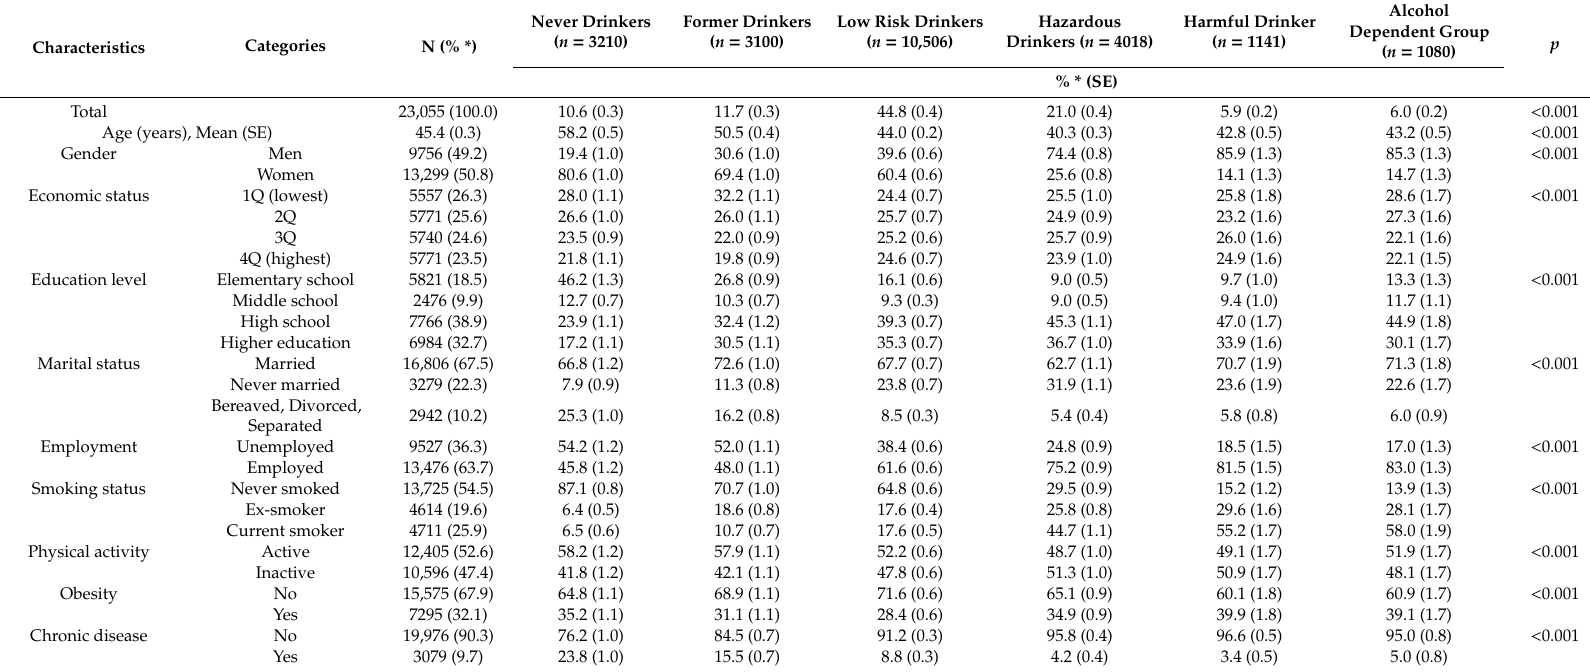
Table 1. Sociodemographic and health-related characteristics of subjects by alcohol drinking